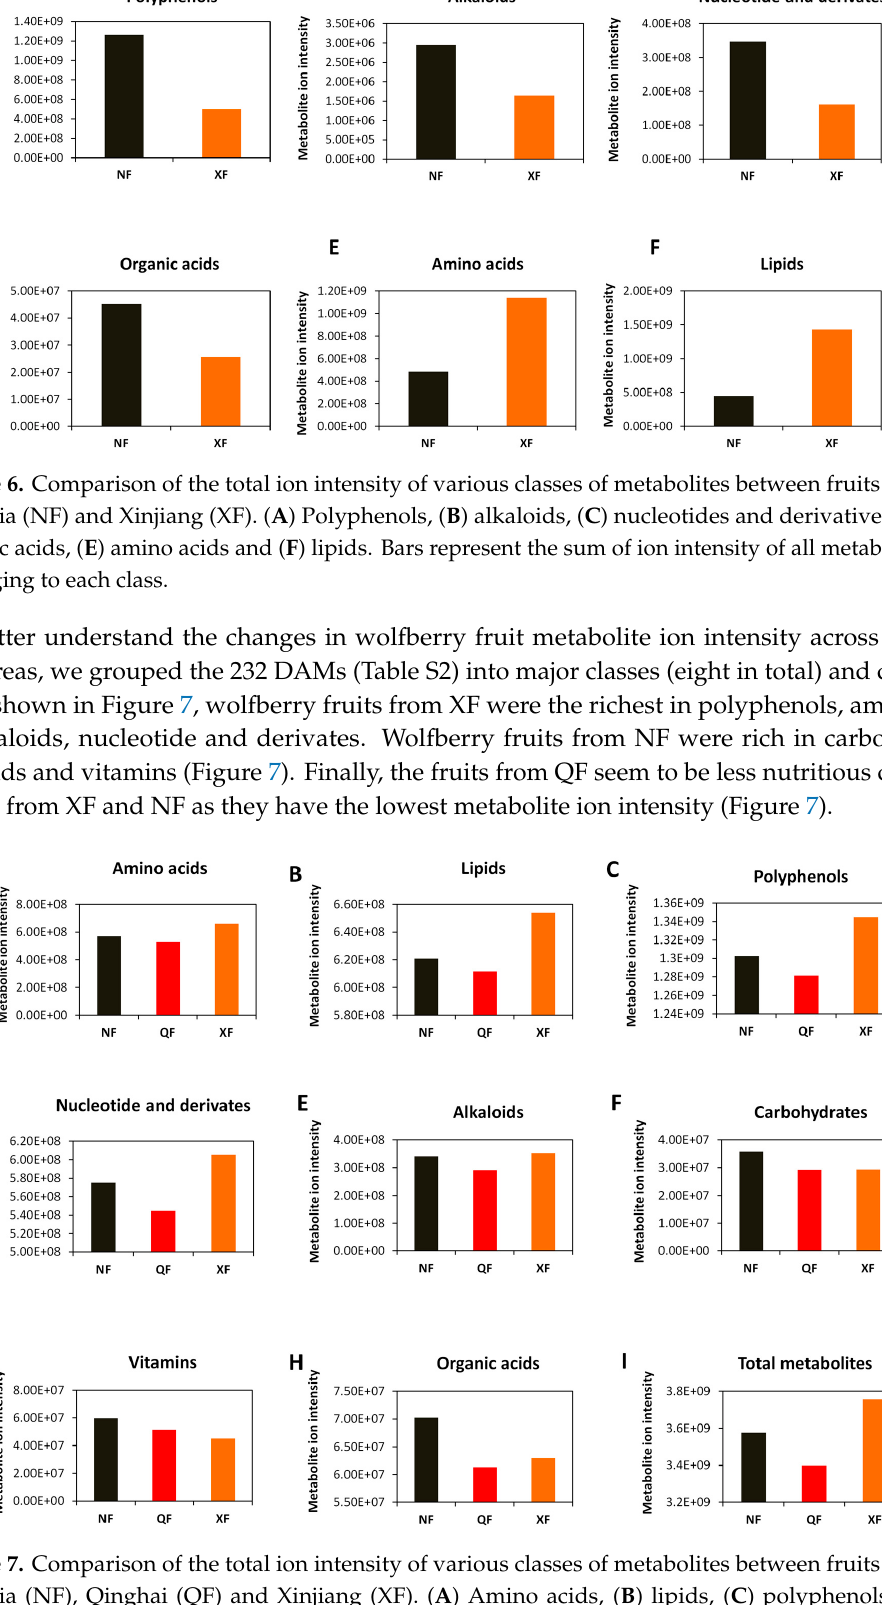
Figure 5. Comparison of the total ion intensity of various classes of metabolites between fruits from Xinjiang (XF) and Qinghai (QF). ( A ) Lipids, ( B ) amino acids, ( C ) alkaloids, ( D ) nucleotides and derivatives, ( E ) polyphenols and ( F ) organic acids. Bars represent the sum of ion intensity of all metabolites belonging to each class.